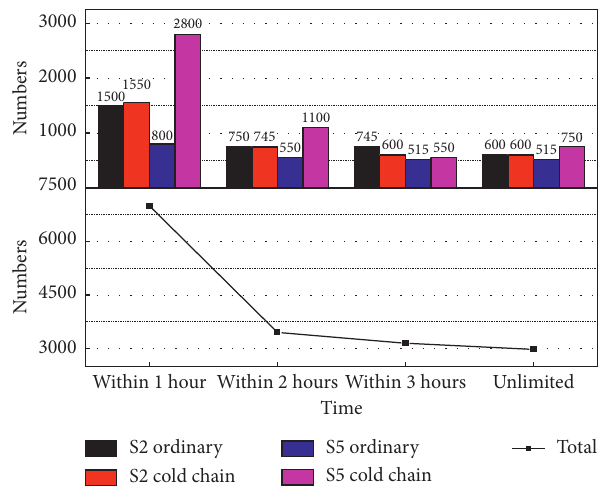
Figure 9: Changes in total system cost under the same time